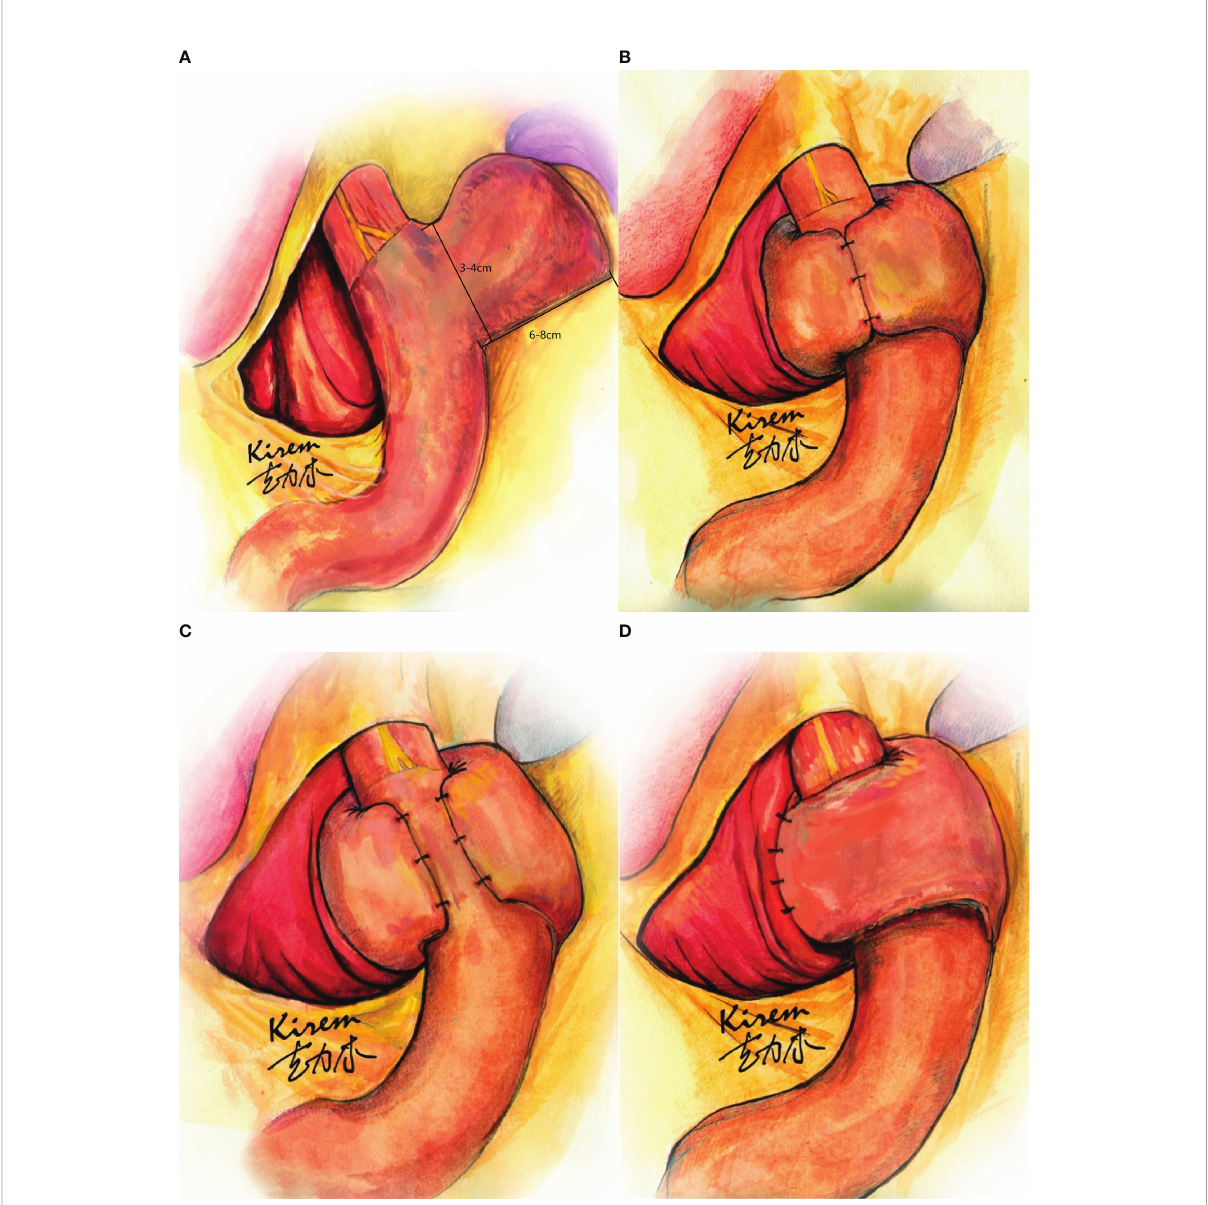
FIGURE 1 Laparoscopic sleeve gastrectomy with fundoplication (LSGFD). (A) Sleeve gastrectomy with preserved fi n shaped fundus; (B) Sleeve gastrectomy with Nissen fundoplication; (C) sleeve gastrectomy with Toupet fundoplication; (D) Sleeve gastrectomy with Dor